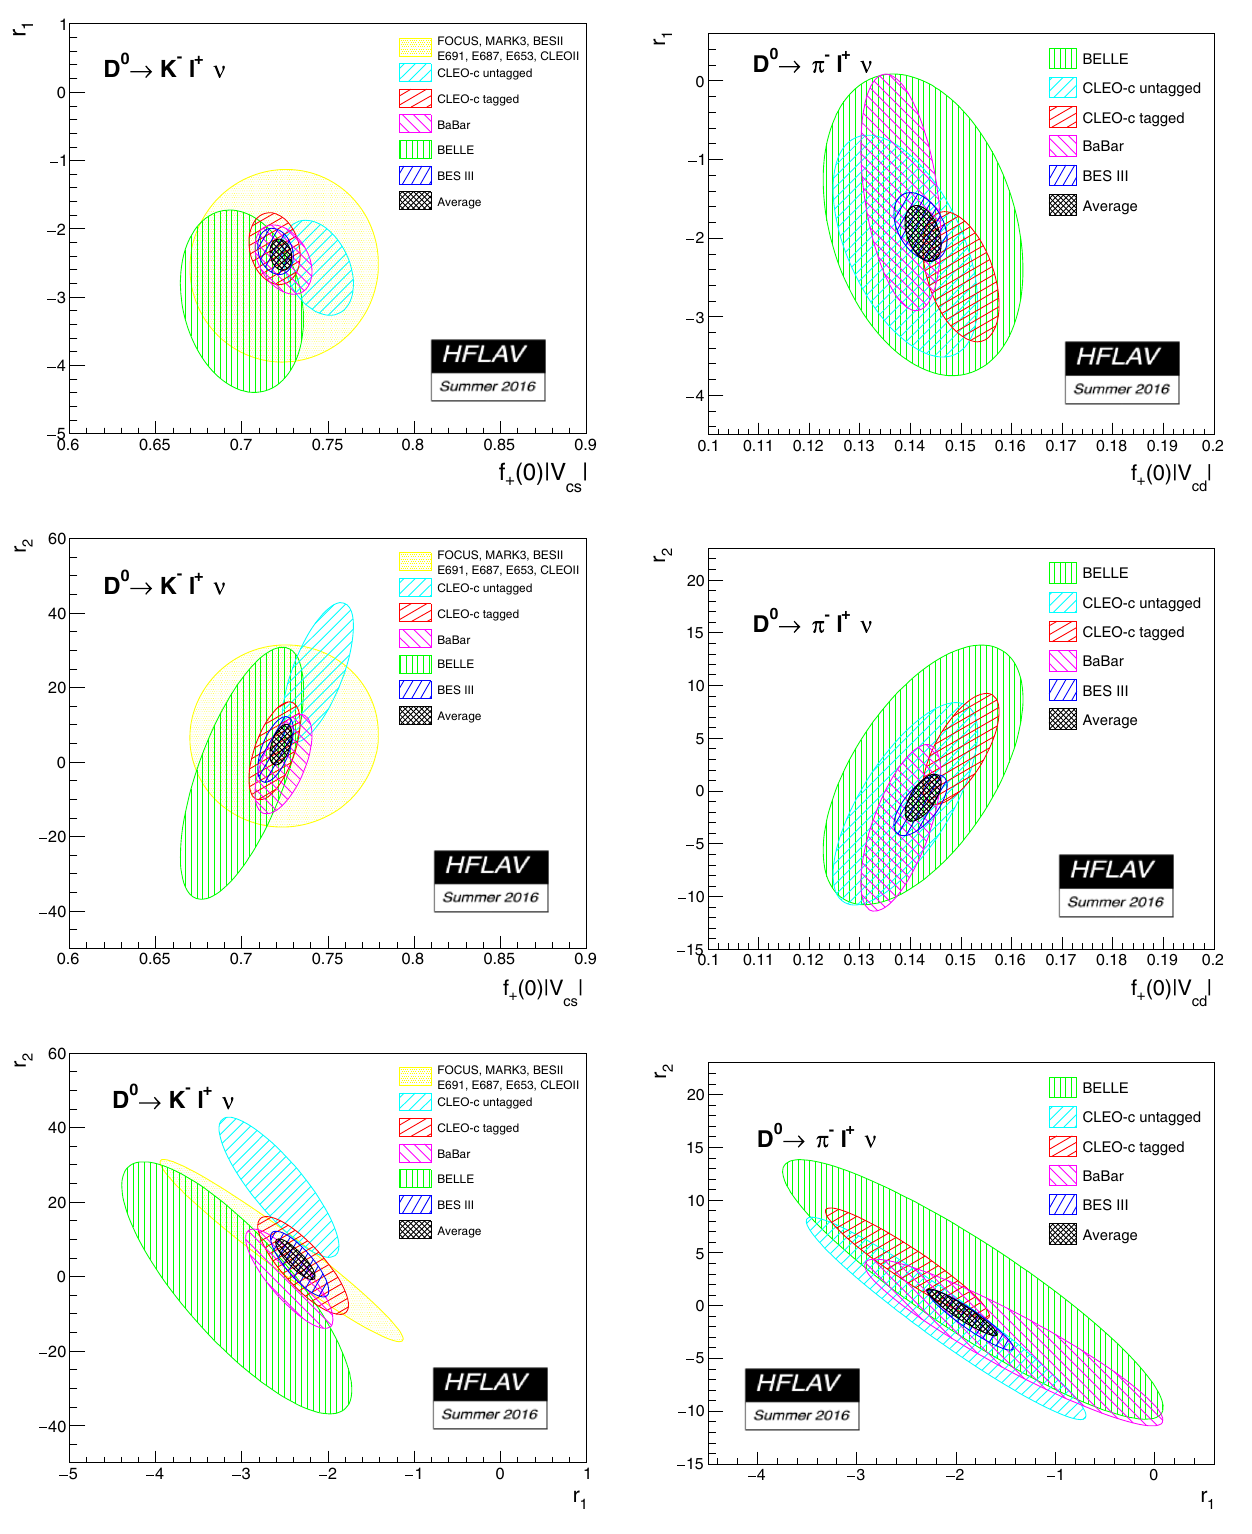
Fig. 201 The D 0 → K − (cid:12) + ν ( left ) and D 0 → π − (cid:12) + ν ( right ) 68% C.L. error ellipses from the average fit of the 3-parameter z -expansion